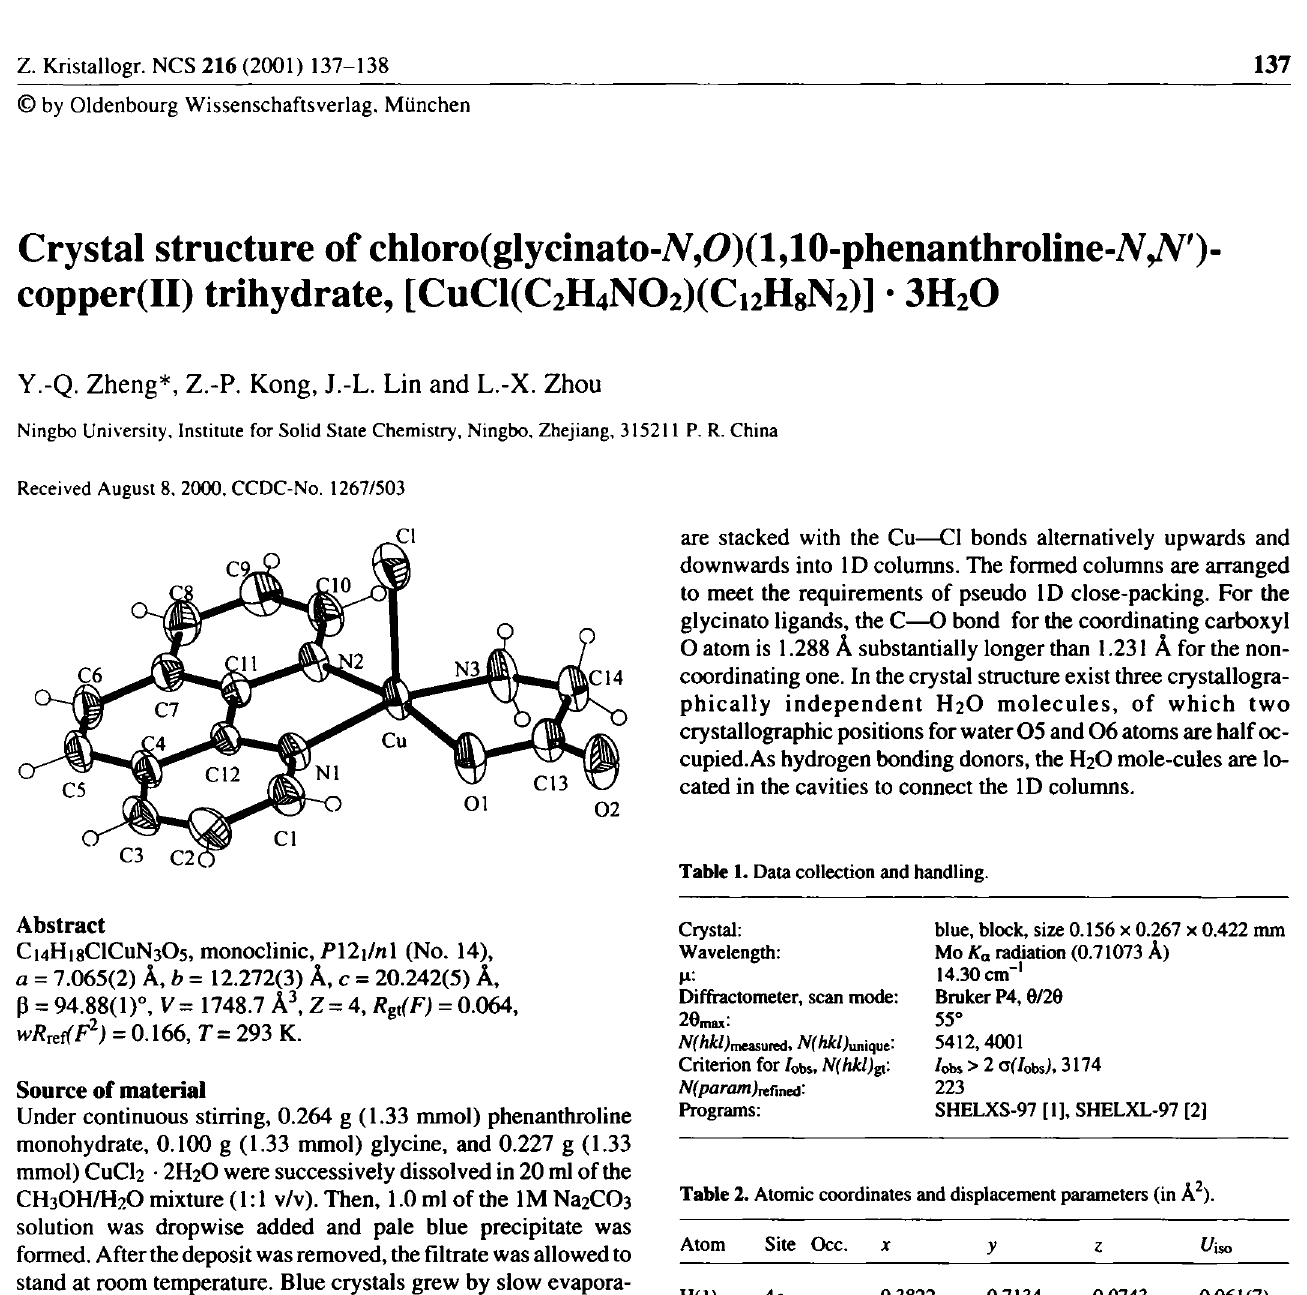
Table 2. Atomic coordinates and displacement parameters (in A 2